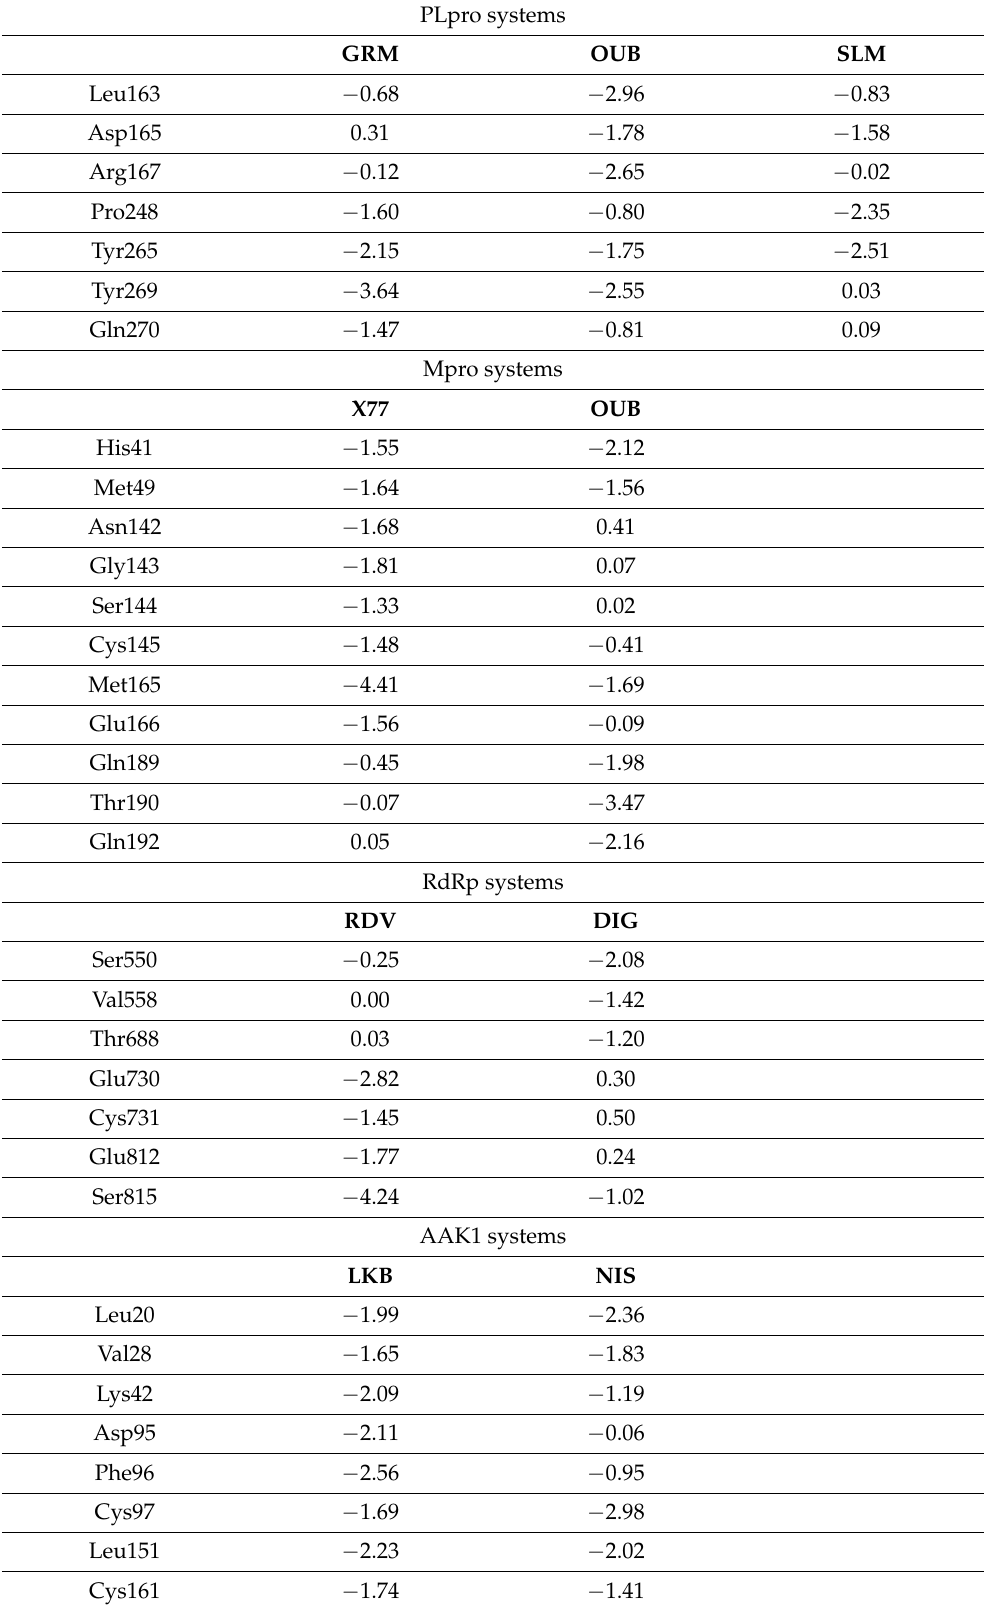
Table 4. Residual decomposition analysis of binding free energies. All values are reported in